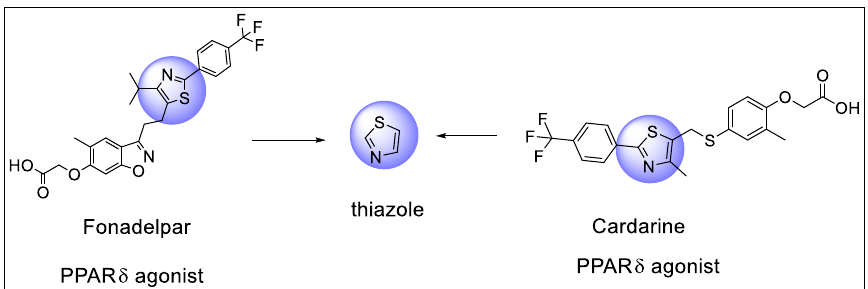
Figure 28. Thiazole scaffold containing PPAR ligands present in the market.